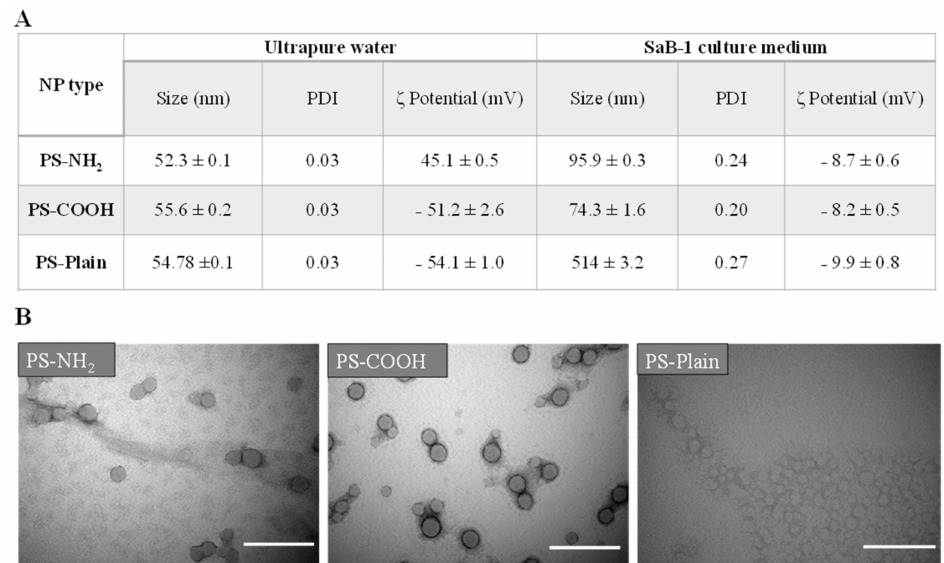
Figure 1. Characterization of the functionalized polystyrene (PS) nanoplastics (NPs). ( A ) Size (nm), polydispersity index (PDI) and zeta ( ζ ) potential mean values of the functionalized NPs, measured by DLS, ± SEM ( n = 3) are presented. ( B ) Representative transmission electron microscopy images of the functionalized polystyrene NPs in a complete culture medium. Scale bar: 200